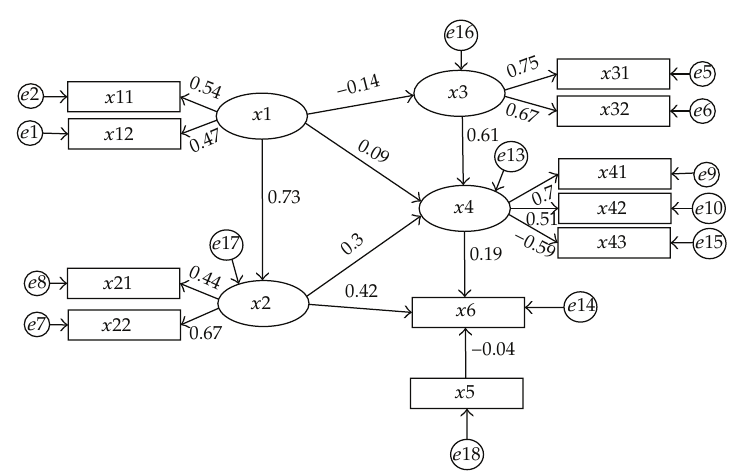
Figure 12: Standard output of model coe ffi